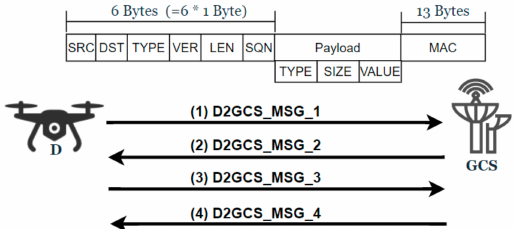
Figure 2. D2GCS communication and packet